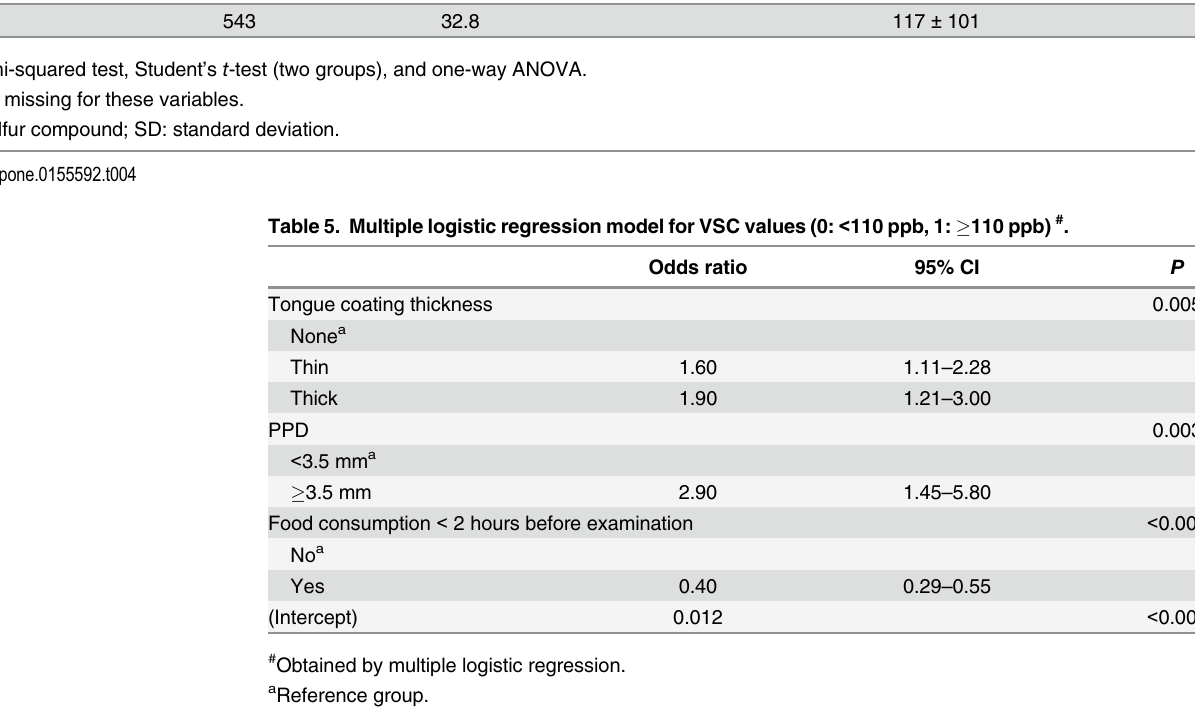
Table 6. Analysis of covariance model for VSC values as continuous variable # . Tongue coating